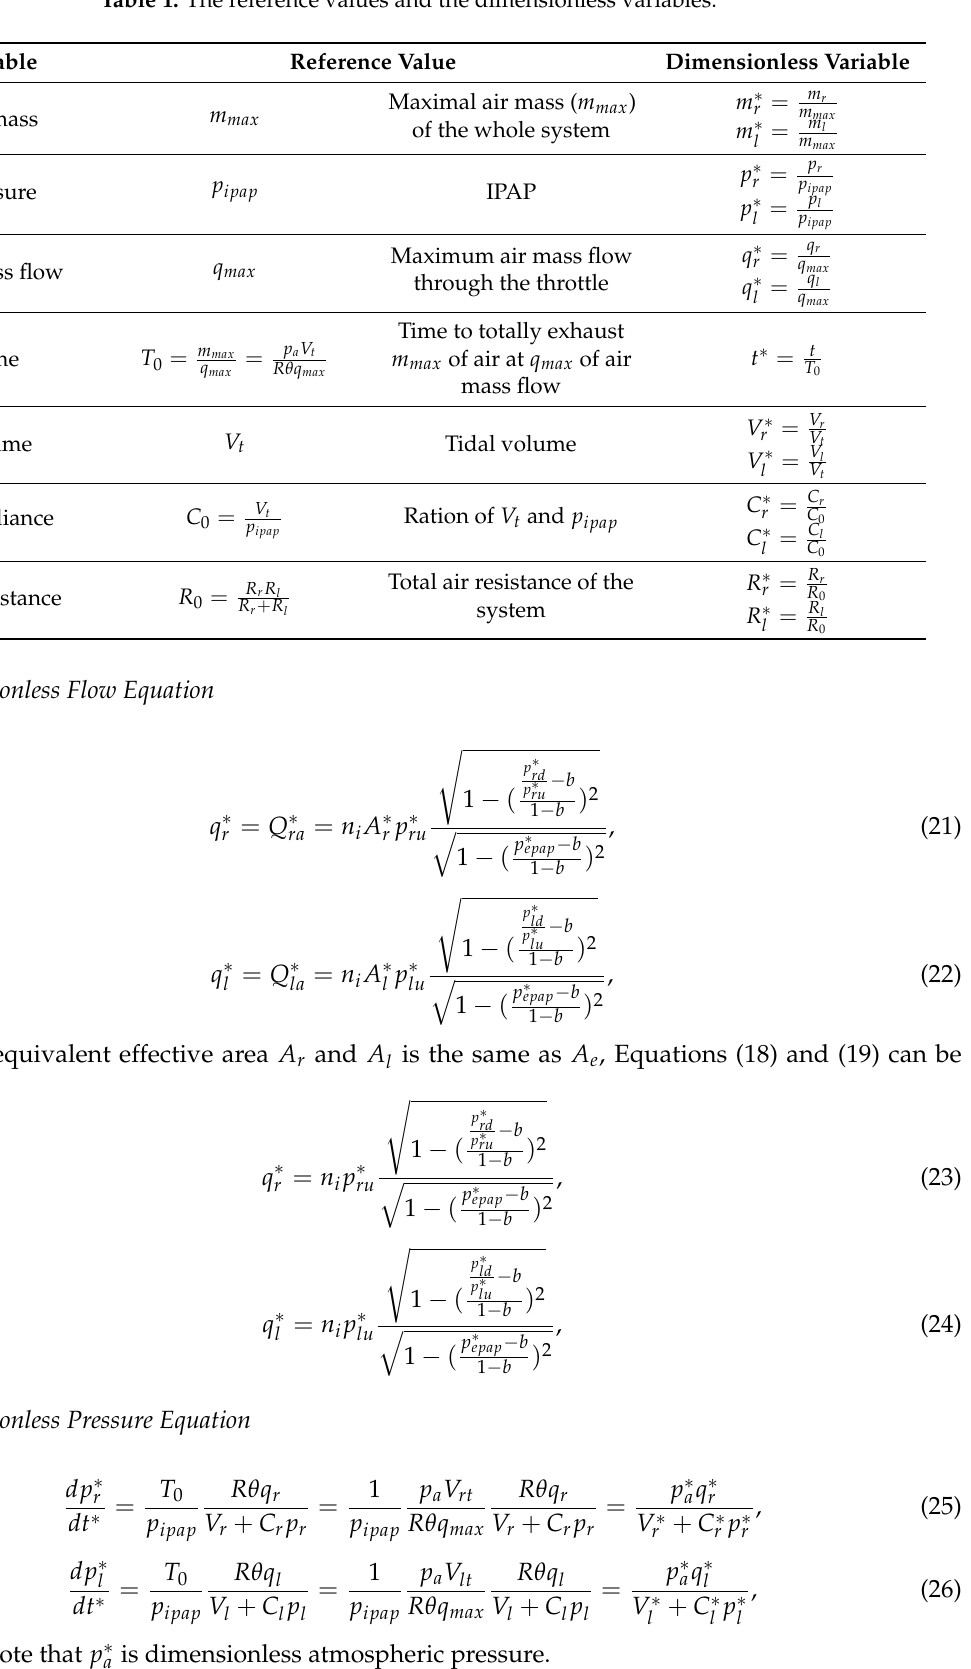
Table 1. The reference values and the dimensionless